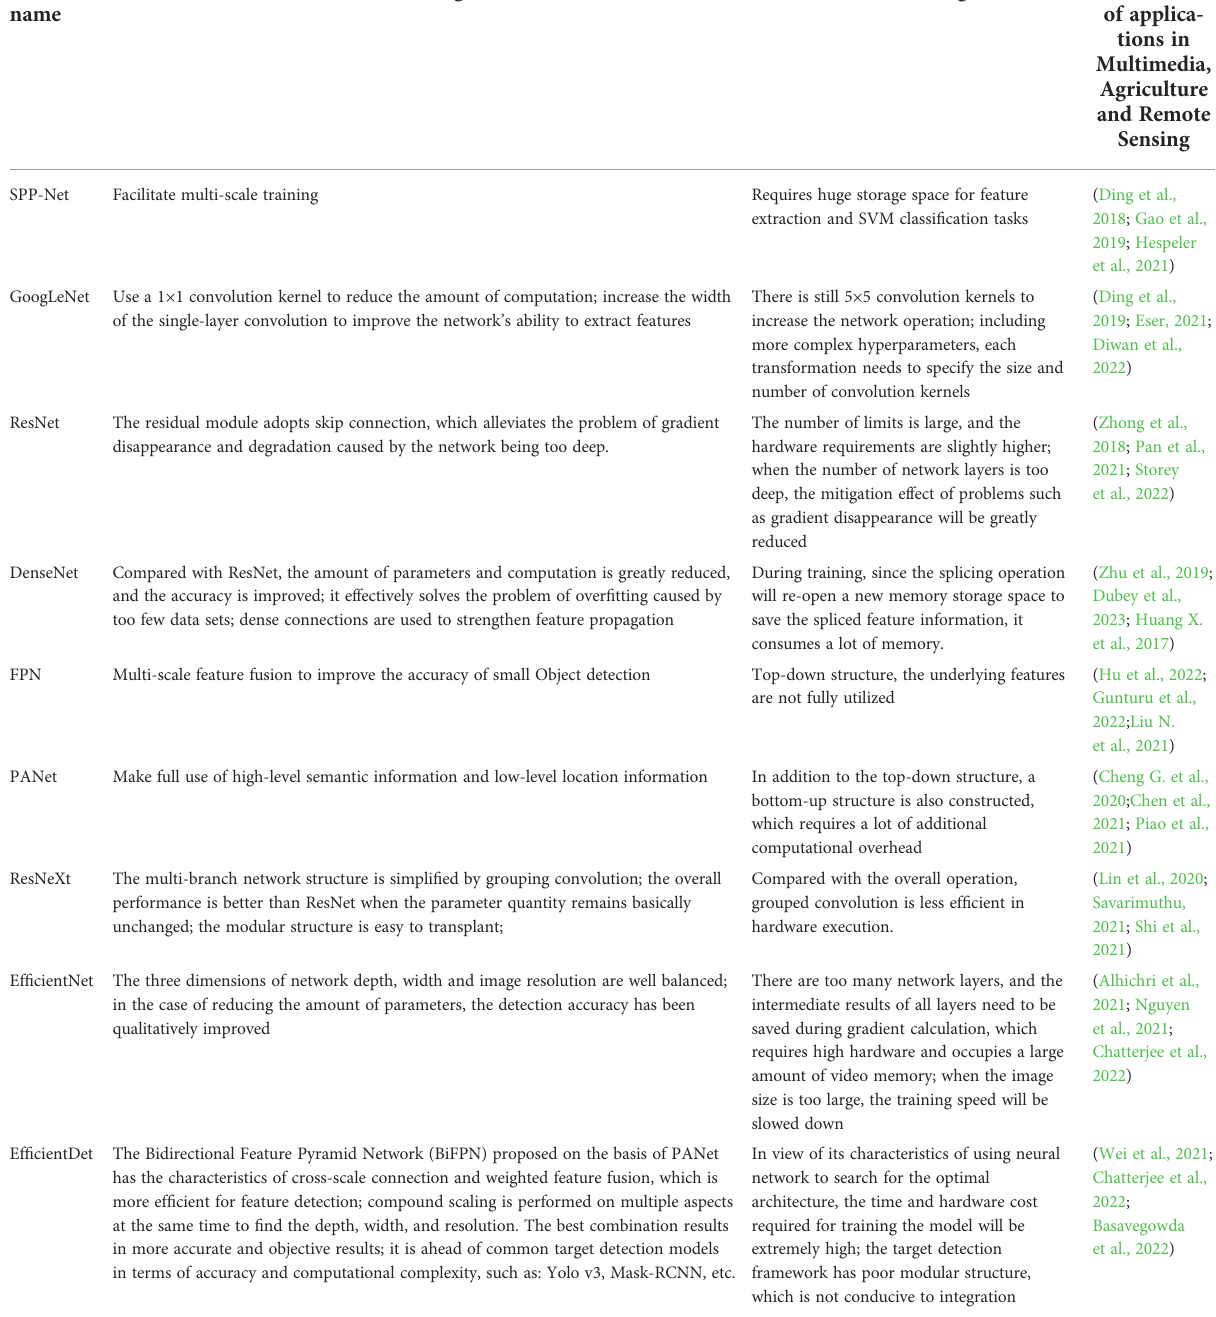
Comparison of advantages and disadvantages of related